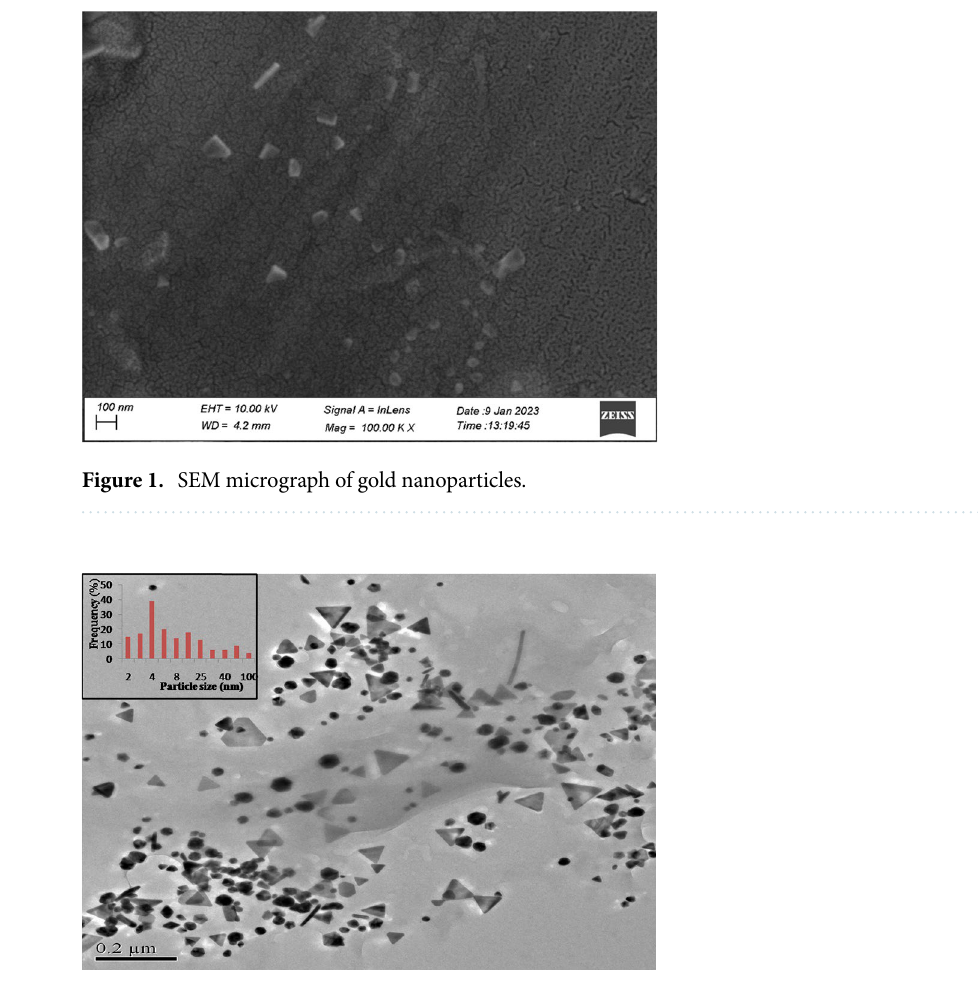
Figure 2. TEM micrograph of gold nanoparticles, inset: size distribution histogram.